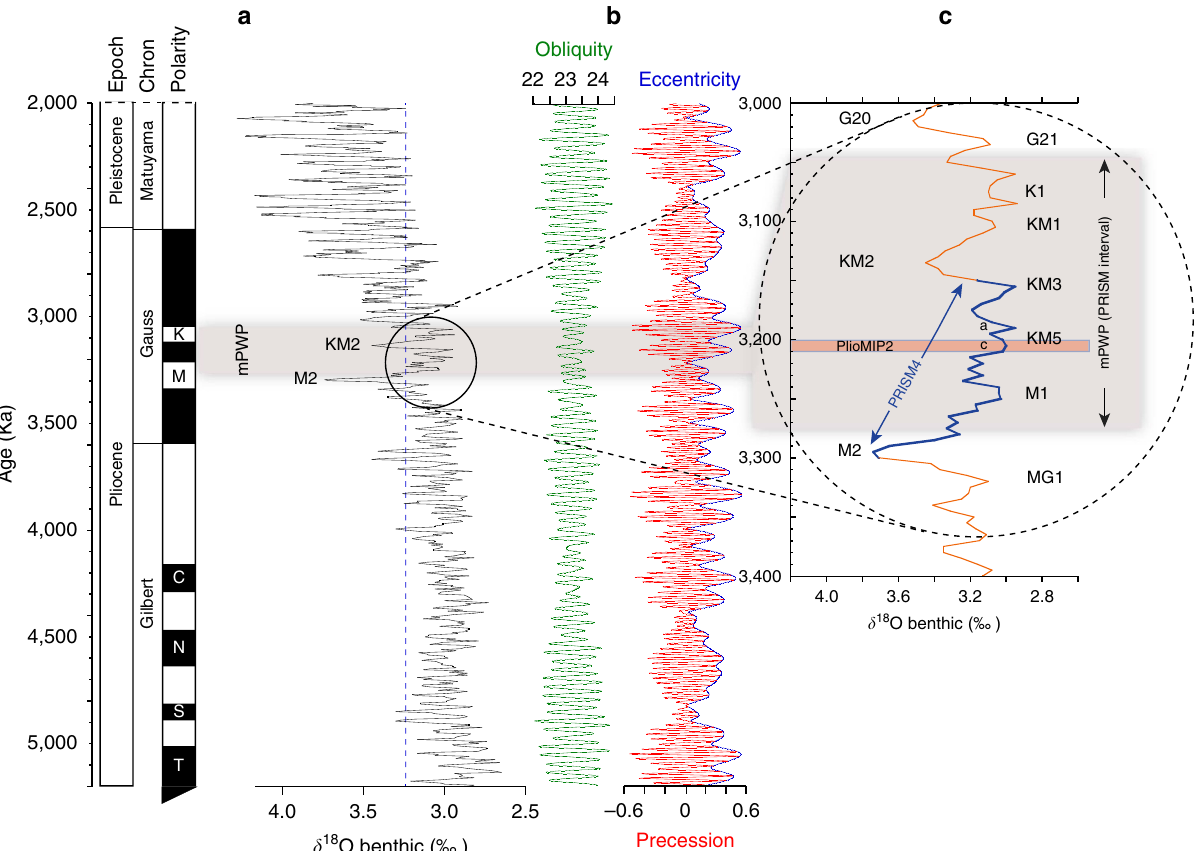
Figure 1 | The Pliocene Research Interpretation and Synoptic Mapping Project Interval. The PRISM interval in relation to the long-term climate evolution of the late Pliocene. ( a ) LR04 benthic oxygen isotope stack and timescale of Lisiecki and Raymo 29 . Vertical dashed line shows present day d 18 O value. The mPWP or PRISM3 warm interval (3.264–3.025Ma) is shown by the horizontal shaded grey bar. ( b ) Laskar et al. 106 values for obliquity ( (cid:2) ), eccentricity and precession. ( c ) Details of LR04 timescale for the mPWP and position of PRISM4 and PlioMIP2 focus. Positions of Marine Isotope Stages MG1, M2, M1, KM5, KM3, KM2, KM1, K1, G21and G20 are